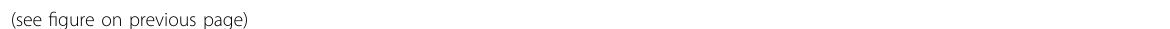
Fig. 4 Unique CASK-Mint1 interaction. a Schematic diagram of the domain organization of Munc18-1, Mint1 and CASK. The fi gure illustrates the detailed boundaries of Mint1-CID and CASK-CaMK. The color coding of the domains is used throughout the entire manuscript except as otherwise indicated. b Analytical gel fi ltration chromatography showing the CASK/Mint1/Munc18-1 complex formation. The eluted peak fractions of OD 280 were further analyzed by SDS-PAGE followed by Coomassie Brilliant Blue staining. The fraction numbers and molecular mass markers are indicated on the top and the left of SDS-PAGE gels. c – f Interactions between various forms of CASK-CaMK and Mint1-CID measured by ITC assay, including Mint1- C-CID (residues 371-397) and CASK(residues 1-337) ( c ), Mint1-CID (residues 338-397) and CASK(residues 1-337) ( d ), Mint1-CID (residues 338-397) and CASK(residues 1-319) ( e ) and Mint1-CID (residues 338-397) and CASK (residues 1-301) ( f ). g Analytical gel fi ltration chromatography showing the stable CASK/Mint1 complex formation. h Ribbon diagram of the structure of the CASK/Mint1 complex. The structure is shown from two different side views with the same color coding in panel A. The secondary structures of CASK-CaMK and Mint1-CID are